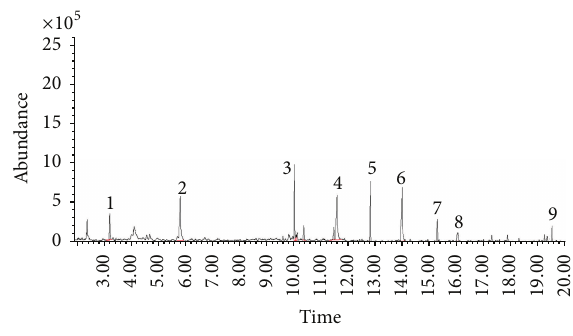
Figure 6: GC/MS chromatogram of phenol solution after being treated by COP for 15 min (peaks 1 and 2: lower carboxylic acids; peak 3: oxalic acid; peak 4: phenol; peak 5: 1,2-dihydroxy benzene; peak 6: 1,4-dihydroxy benzene; peak 7: 4-hydroxy-benzoic acid; peak 8: propylphenol; peak 9: phenoxyphenol), [ phenol ] 𝑜 = 500 mg/L; initial pH of 8